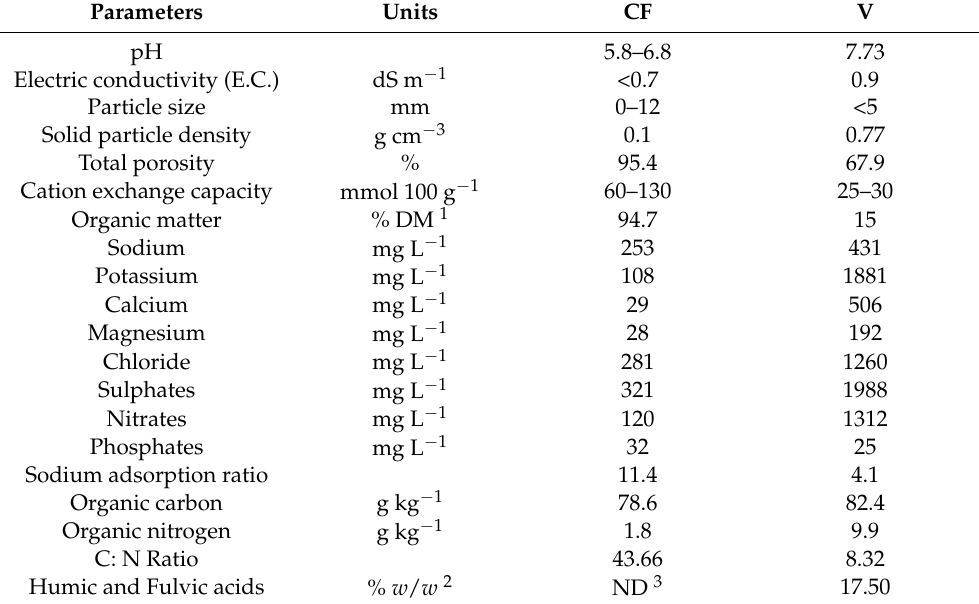
Table 3. Physicochemical characterization of the initial coconut fiber (CF) and vermicompost (V) used for substrate mixtures (20V80CF (control), 40V60CF, 60V40CF) in the experiment. Parameters Units CF pH Electric conductivity